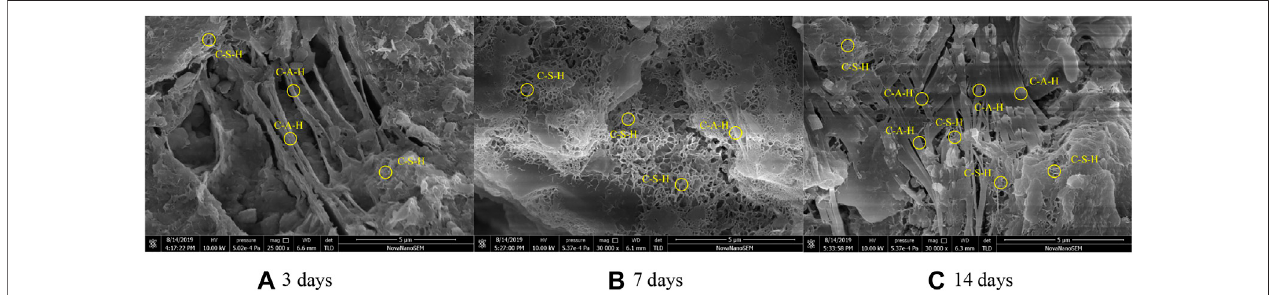
FIGURE 9 | SEM image of the one-part geopolymer-stabilized soft clay with 90% GGBFS and 10% FA at 4.64 mol/L NH solution: (A) 3 d; (B) 7 d; (C) 14 d.